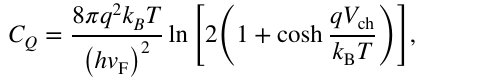
Fig. 3c, d, the average mobility parameters of several anti‑